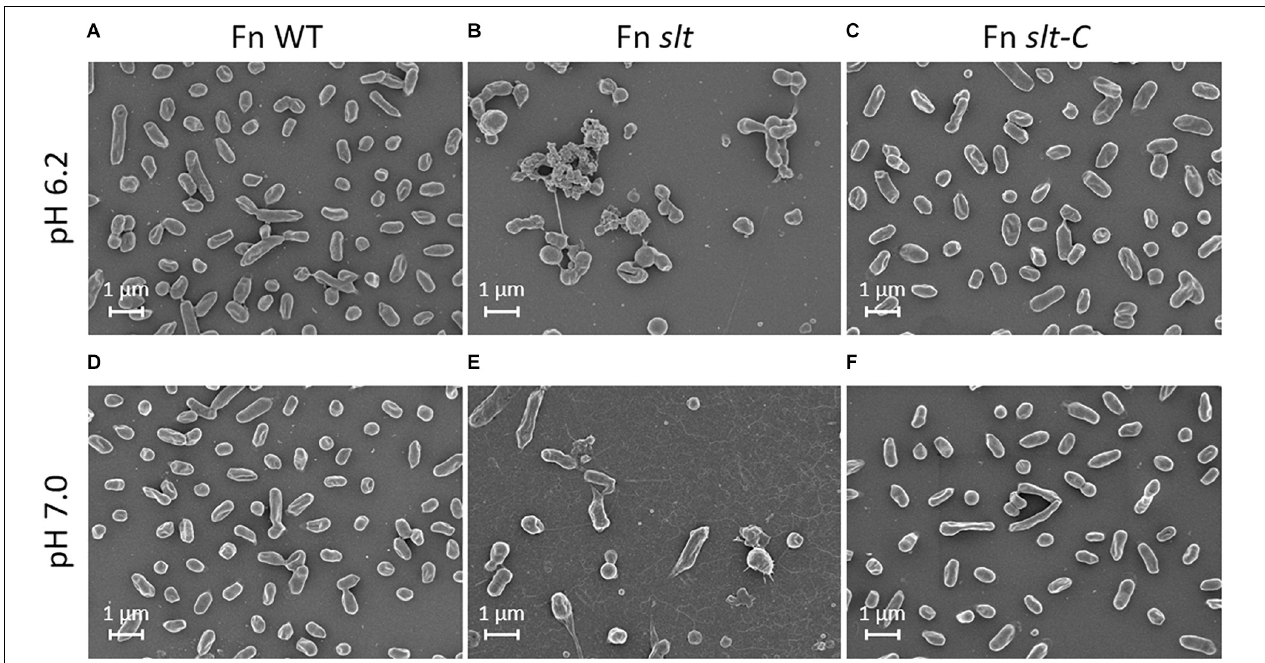
FIGURE 3 | Scanning electron microscopy analysis of Fn strains. Fn WT, slt , and slt -C strains were grown to exponential phase in CDM adjusted to pH 6.2 (top panels; A–C ), or pH 7.0 (bottom panels; D–F ), and analyzed by SEM. Images were acquired under 10,000 × magnification; scale bar, 1 µ m.